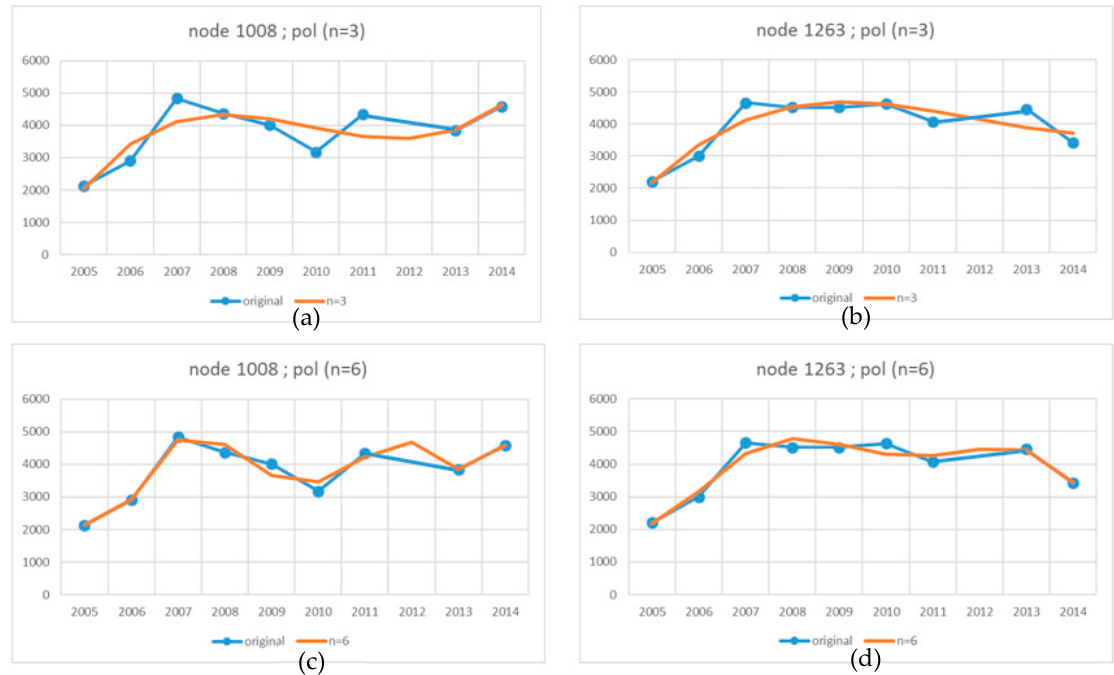
Figure 7. A comparison of changes in the original value and the forecast value in two selected nodes in successive measurement epochs for different degrees (n) of polynomials generated in the absence of the 2012 epoch; ( a ), ( c )—node 1008; ( b ), ( d )—node 1263 (node location is shown in Figure 3b). Source: own elaboration.